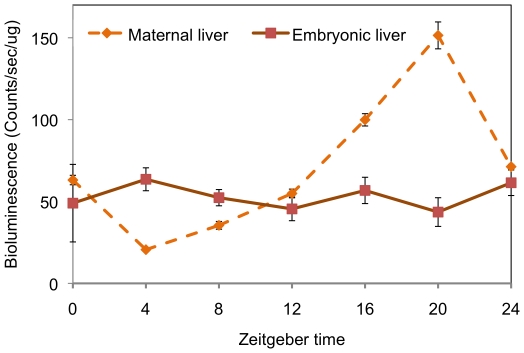
Acute luciferase activity in embryonic and maternal liver.
Per2::luc mice were used to make protein extracts from maternal and embryonic liver samples every four hours for 24 hours, during E18-19. Luciferase activity was measured as described in Methods. Maternal tissues showed a distinct peak and trough in PER2 levels, at ZT20 and ZT4. In contrast, embryonic liver showed no significant differences during the 24-hour period. Symbols represent the mean ± standard error of the mean (SEM) of three embryos per time point and three technical replicates from a single mother.